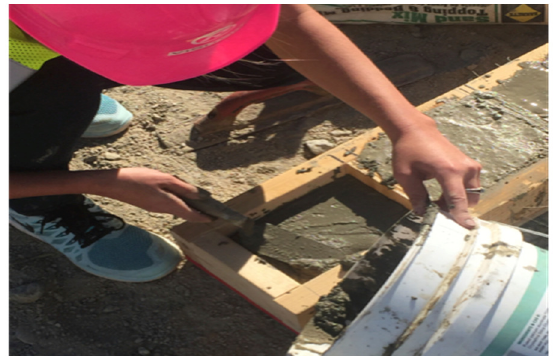
Fig. 8: Mixing the concrete and pouring it into the mold